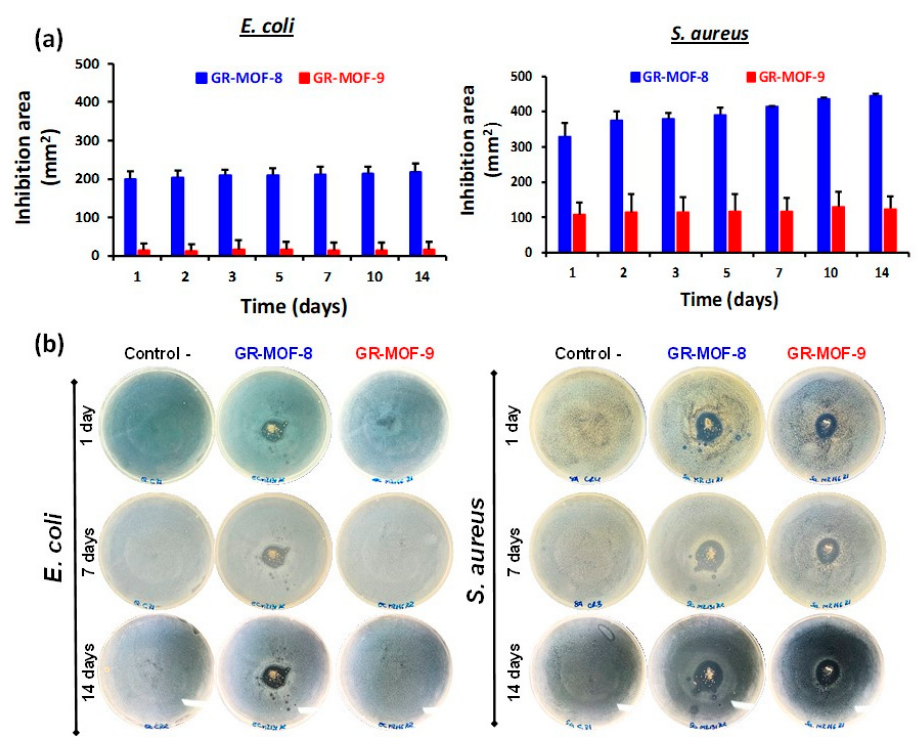
Figure 3 . ( a ) Halo inhibition zone (expressed in mm 2 ) for GR-MOF-8 (blue) and GR-MOF-9 (red) along 14 days with EC ( left ) and SA culture ( right ) in agar plates at 37 °C. Error bars represent standard deviation; ( b ) representative images of inhibition experiments with EC and SA culture corresponding to GR.MOF-8 and 9 after diverse contact times.